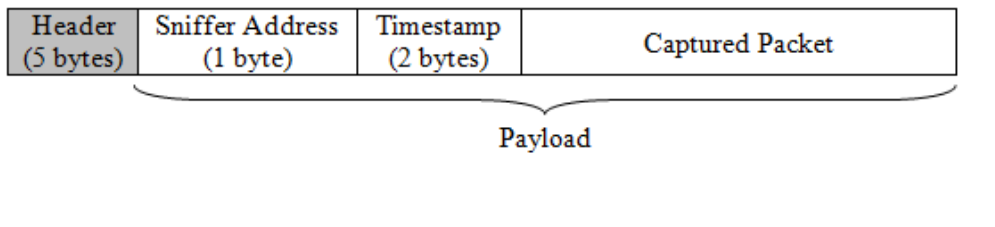
Figure 4. Format of the packet sent by sniffers without using aggregation of